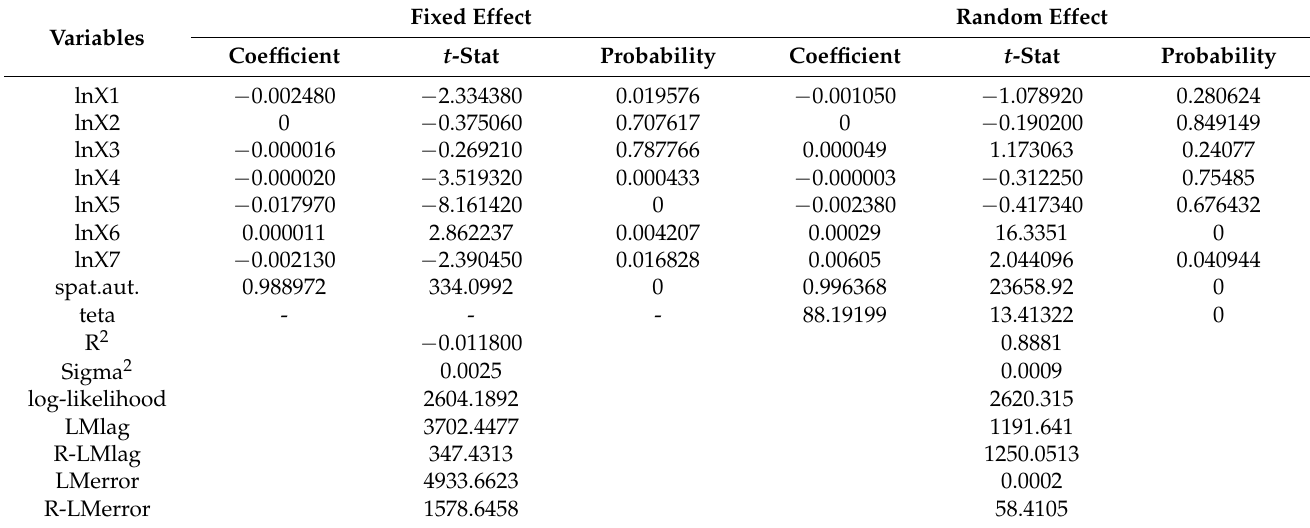
Table 7. Estimation results of spatial error evaluation model for urban human settlements